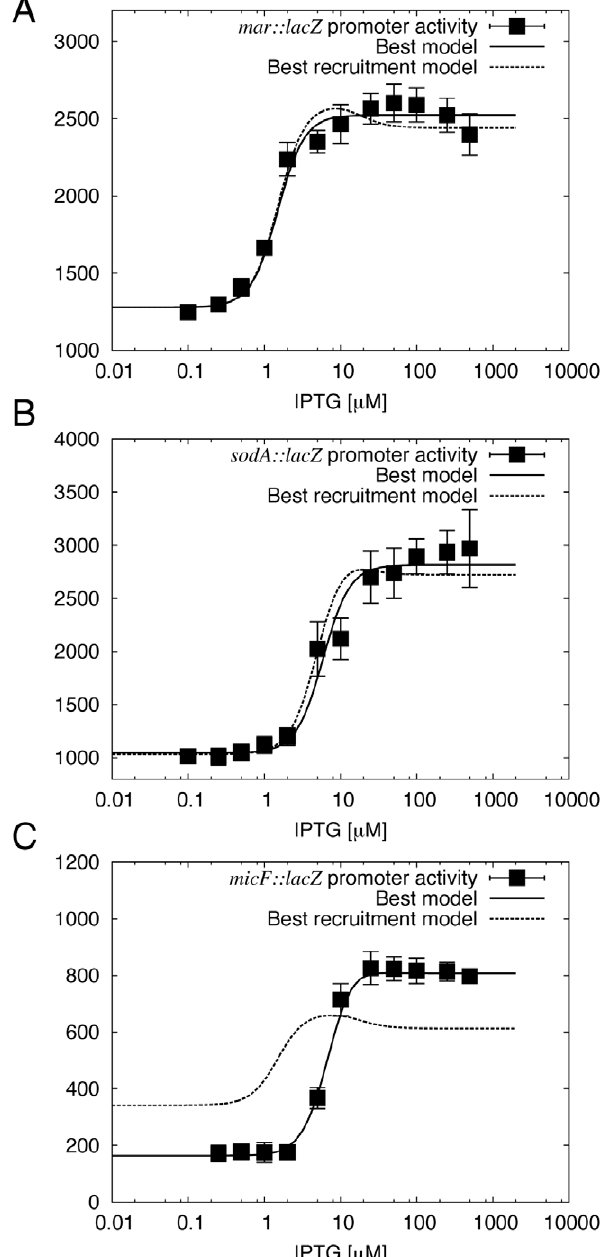
Figure 2. Fits of the best models of promoter activity. A) marRAB ; B) sodA ; C) micF . Error bars for the data correspond to the standard error of the mean calculated from multiple trials (Table S1). Corresponding x 2 and parameter values are given in Table